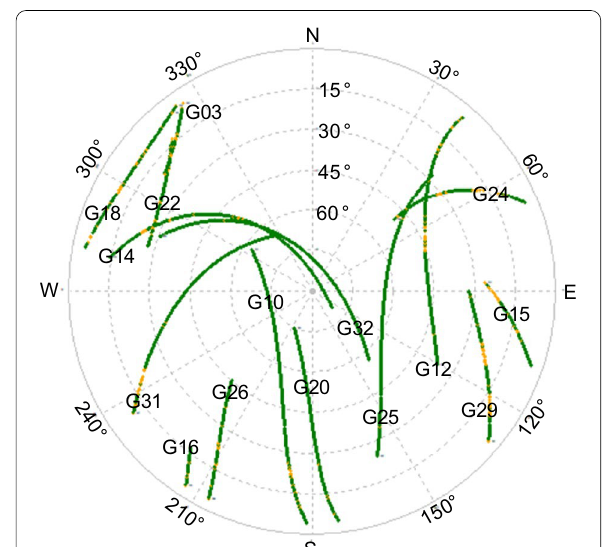
Fig. 11 GPS satellite sky plot of ship-borne dynamic test